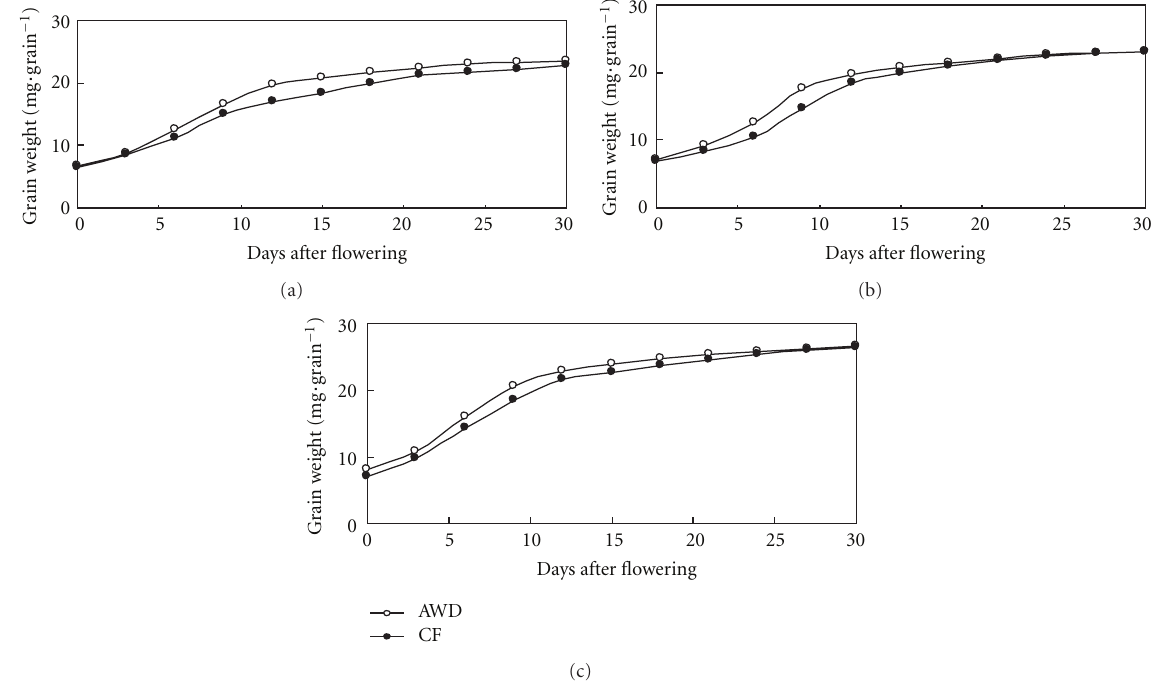
Figure 4: Grain weight after flowering under AWD and CF in 2010 DS. Three varieties IR72 (a), IR82372H (b), and SL-8H (c) were used in the experiment at high N